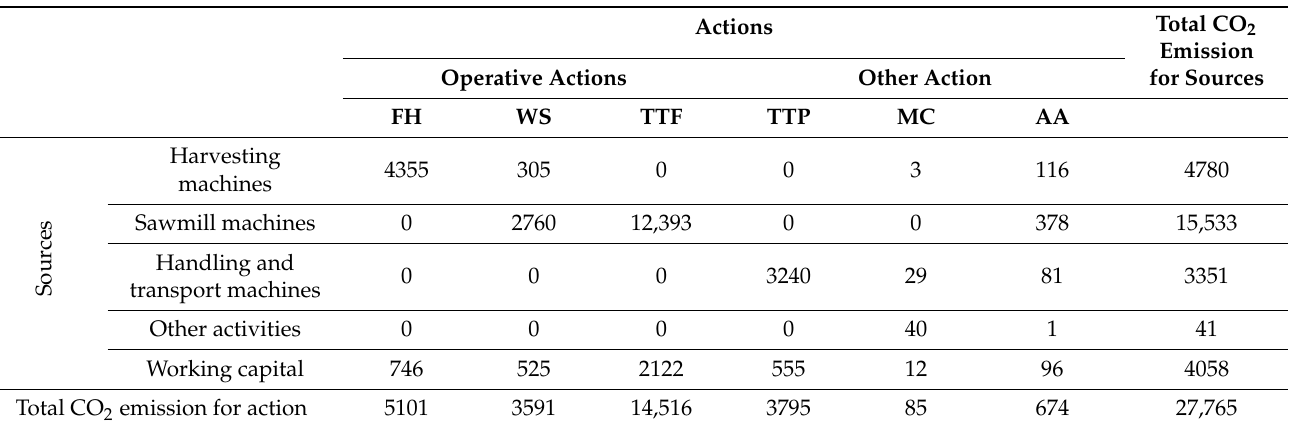
Table 12. CO 2 emissions by sources and actions. Data expressed in kgCO 2 . Legend: WWM: